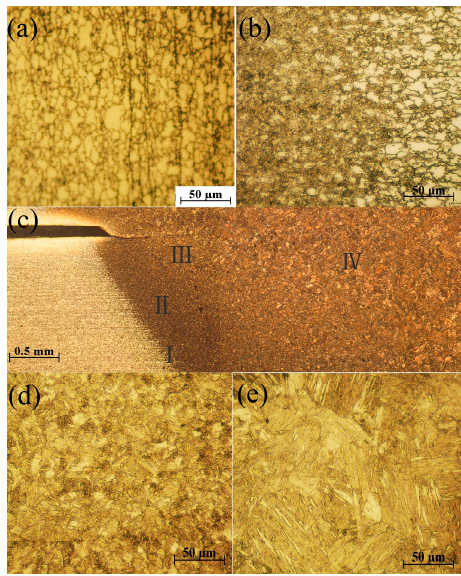
Figure 14. The microstructure of the welding joints: ( a ) dual-phase region (I in Figure 14c); ( b ) fine grained region (IIin Figure 14c); ( c ) metallographic structure of the weld nugget; ( d ) overheated zone (III in Figure 14c); and ( e ) fusion zone (IV in Figure 14c).